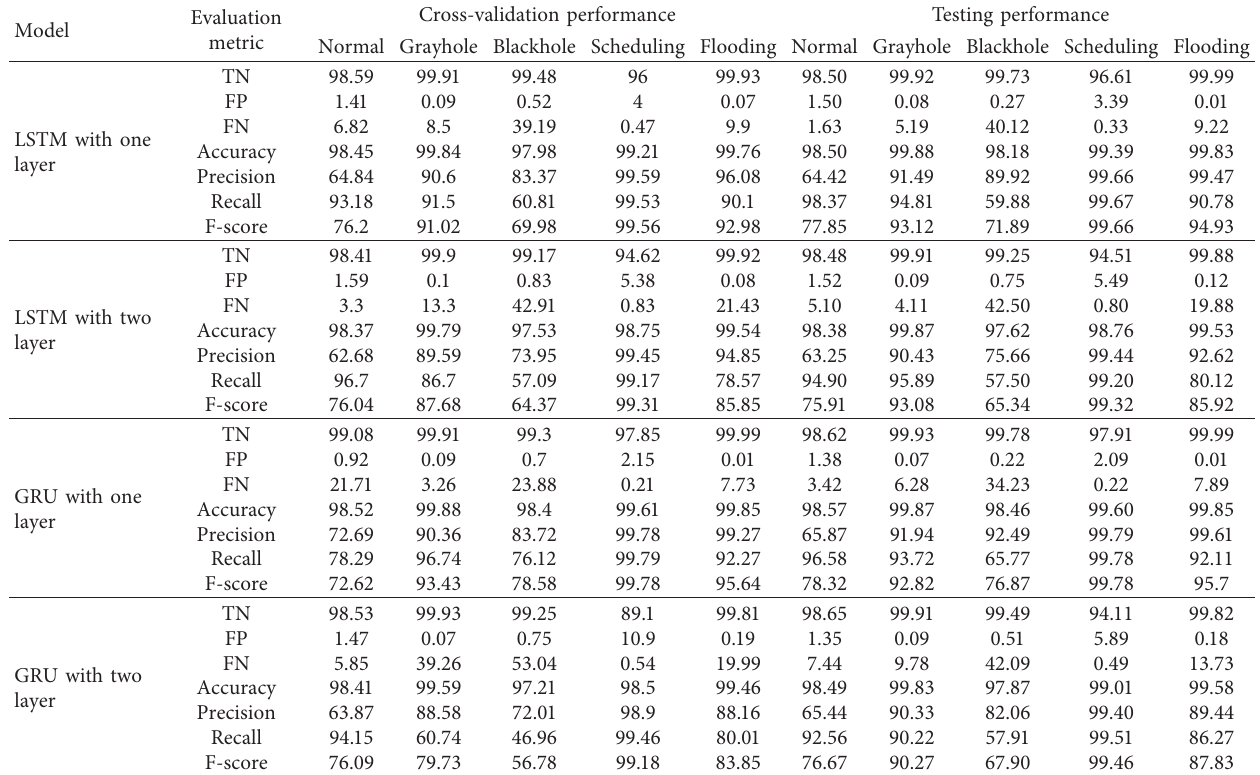
Table 13: The performance of deep learning for WSN dataset using LSTM and GRU with selected features. Cross-validation Evaluation Model metric